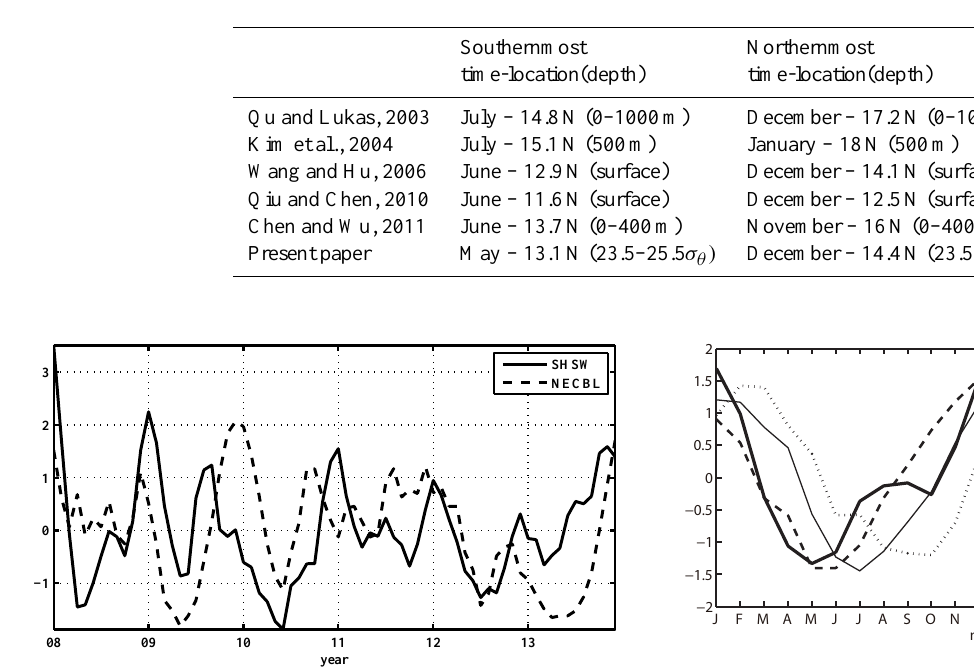
Table 1. Seasonal variation of NECBL by different studies.